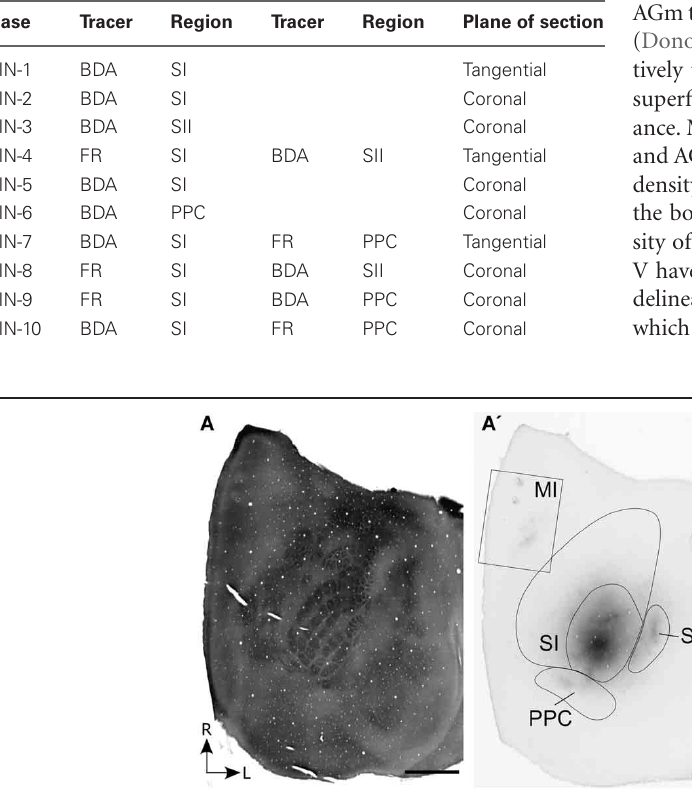
FIGURE 1 | Corticocortical projections from SI barrel cortex terminate at MI sites located lateral to the sites most effective for evoking whisker movements. (A) Tangential section processed for cytochrome oxidase (CO) shows the spatial distribution of the layer IV barrels in SI cortex. (A (cid:2) ) An adjacent section processed for biotinylated dextran amine (BDA) shows the location of BDA deposits in SI barrel cortex. Contour lines indicate the primary (SI) and secondary (SII)